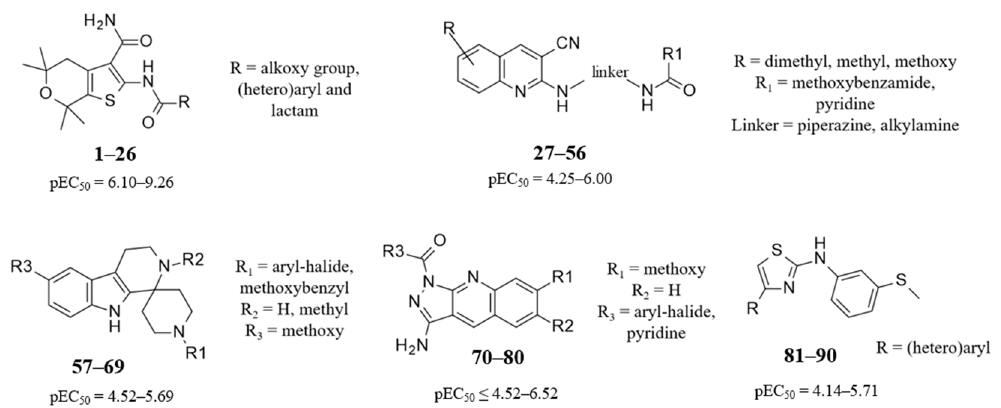
Figure 1. Chemical structure and biological activity of the selected series of F508del-CFTR potentiators. Potency of the compounds has been described as the negative logarithm of the half maximal e ff ective concentration (pEC 50 ), reported as molar